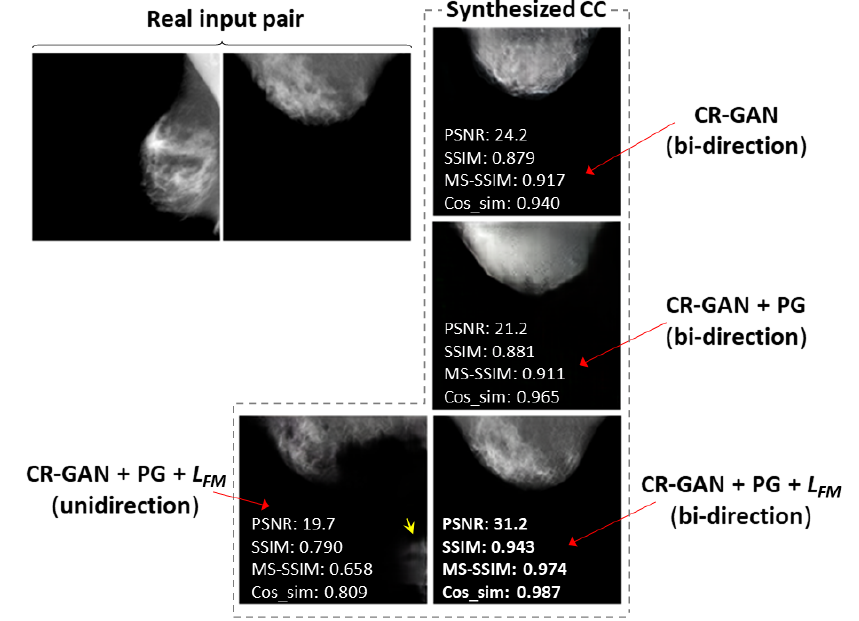
Figure 6. Comparison of CC views at 128 × 128 resolution synthesized by training methods. Examples chosen of a successful case using bi-directional training with PG technique and feature matching loss. The yellow arrows indicate artifacts outside the